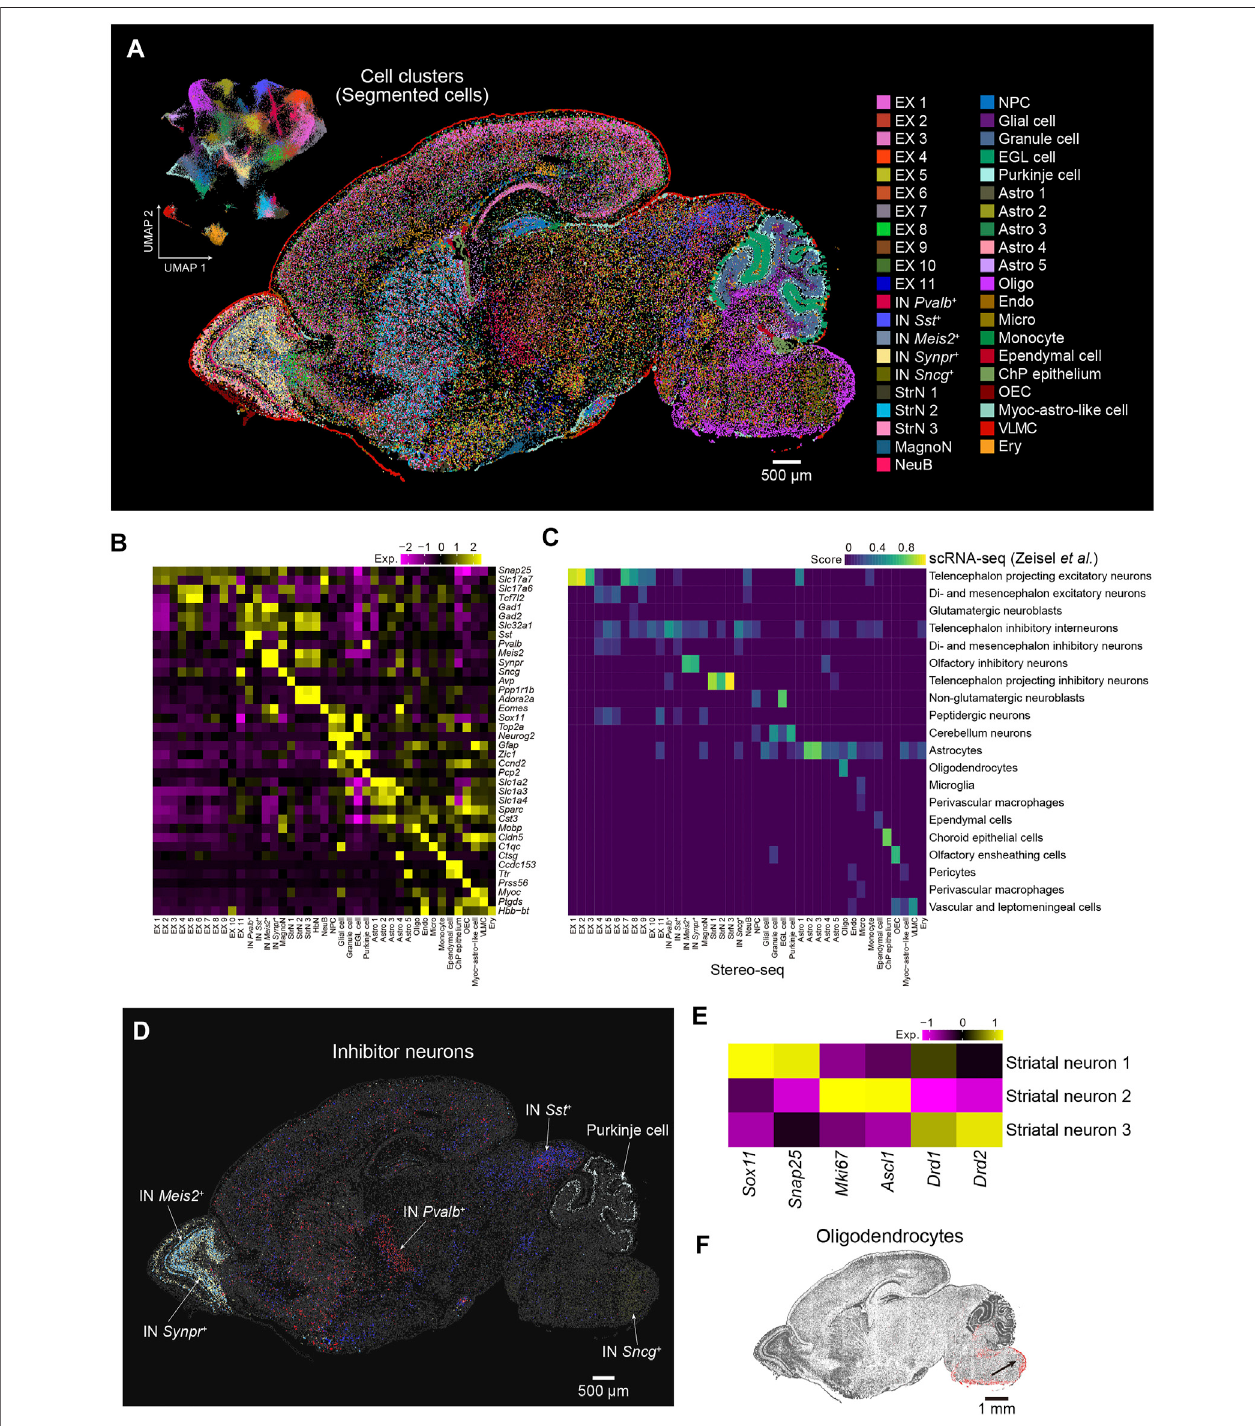
FIGURE 3 | Spatial distribution of cell types in the P7 mouse brain. (A) Left: UMAP visualization of the segmented cells from the P7 mouse brain section 1 . Right: Spatial visualization of cell types shown in the left panel for the whole brain section 1 . Cells are colored by the annotations. EX, excitatory neuron; IN, inhibitory neuron; MagnoN, magnocellular neuron; StrN, striatal neuron; NeuB, neuroblast; NPC, neuron progenitor cell; EGL cell, external granular layer cell; Astro, astrocyte; Oligo, oligodendrocyte; Endo, endothelium; Micro, microglia; ChP epithelium, choroid plexus epithelium; OEC, olfactory ensheathing cell; Myoc-astro-likecell, myoc-expressing astrocyte-like cell; VLMC, vascular leptomeningeal cell; Ery, erythrocyte. Scale bar, 500 µm. (B) Heatmap of normalized expression of selected marker genes for the 41 cell types of the P7 mouse brain shown in (A) . (C) Correspondence between the cell types shown in A by Stereo-seq and the cell clusters identi fi ed by reported scRNA-seq (Zeisel et al., 2018). (D) Spatial visualization of different subtypes of inhibitor neuron clusters shown in (A) . Scale bar, 500 µm. (E) Heatmap of normalized expression of the indicated genes for the three striatal neuron types shown in (A) . (F) Spatial visualization of oligodendrocytes shown in (A) . Scale bar, 1 mm.